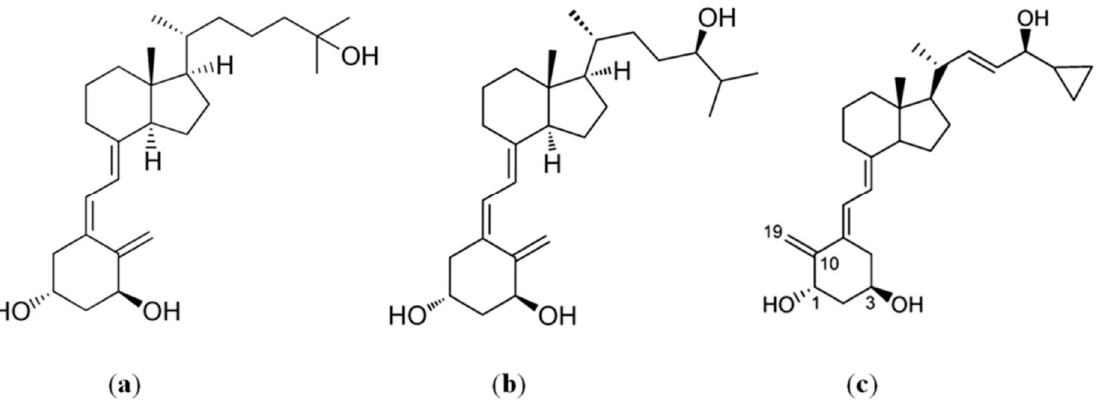
Figure 1. Chemical structure of ( a ) calcitriol, ( b ) PRI-2191 and ( c ) PRI-2205.